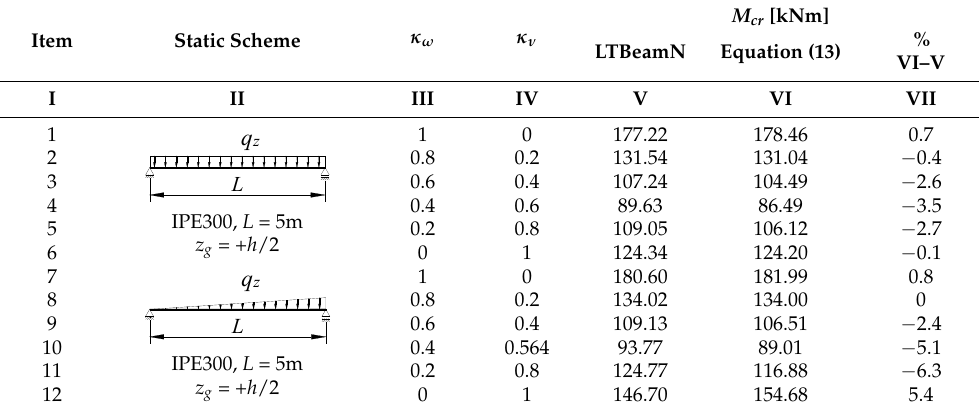
Table 7. Comparison of M cr for beam IPE300 ( L = 5 m).